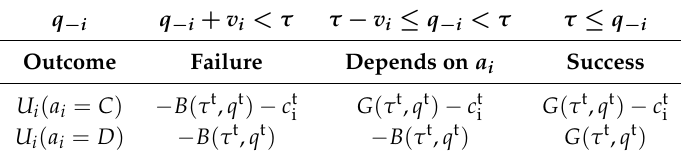
Table 2. Definition of utilities for agent i . Let q − i = ∑ j ∈ A excluding agent i , and τ be the global requirement. This game qualifies as a threshold public goods game if G ( τ , q ) + B ( τ , q ) > c i , which is always verified for large enough values of G or B